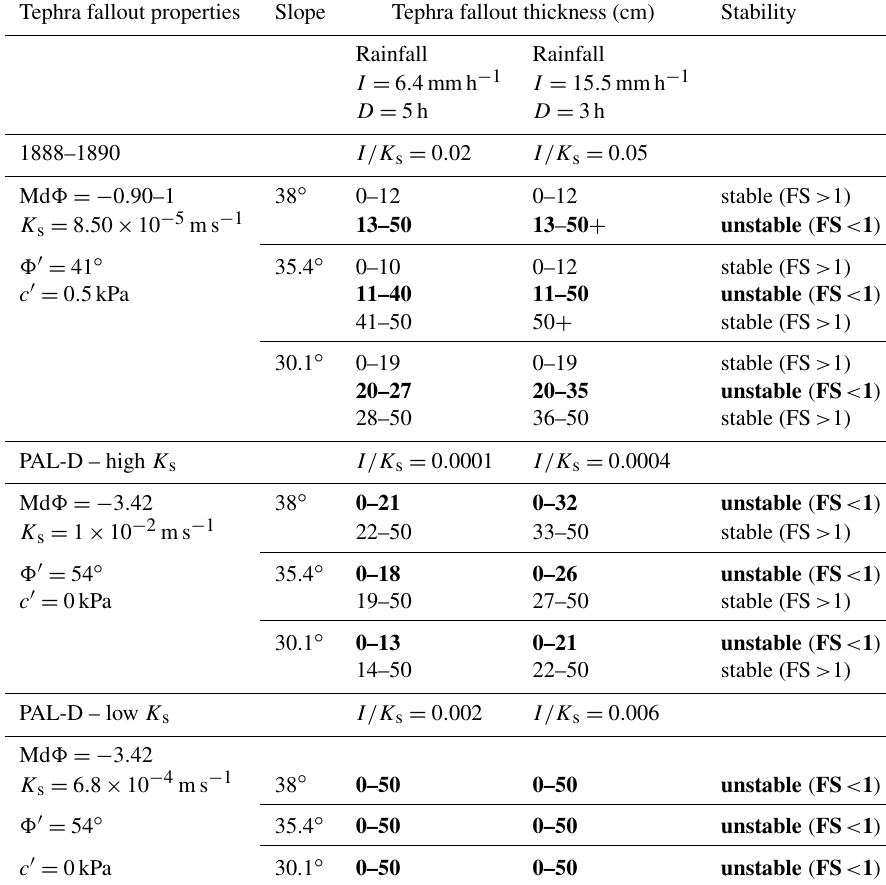
Table 6. Summary description of outcomes of Figs. 11 and 12 showing the relation between tephra fallout deposit thickness and the factor of safety (FS) based on various key parameters (i.e. tephra fallout properties, slope angle, rainfall intensities). Unstable deposit thickness is shown in bold. The ratio between rainfall intensity and hydraulic conductivity ( I/K s ) is also shown as an indication of the time for the rainfall water to reach the bottom of the deposit. Tephra fallout properties Slope Tephra fallout thickness (cm) Stability Rainfall